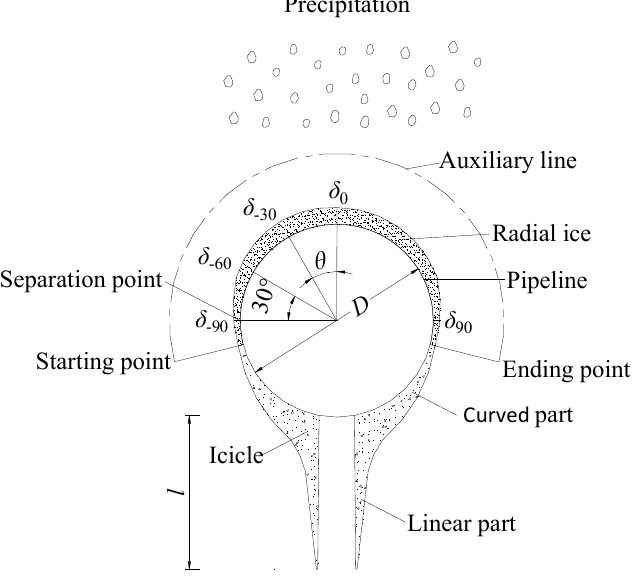
Figure 4. Symbol definition of ice accretion on pipeline.